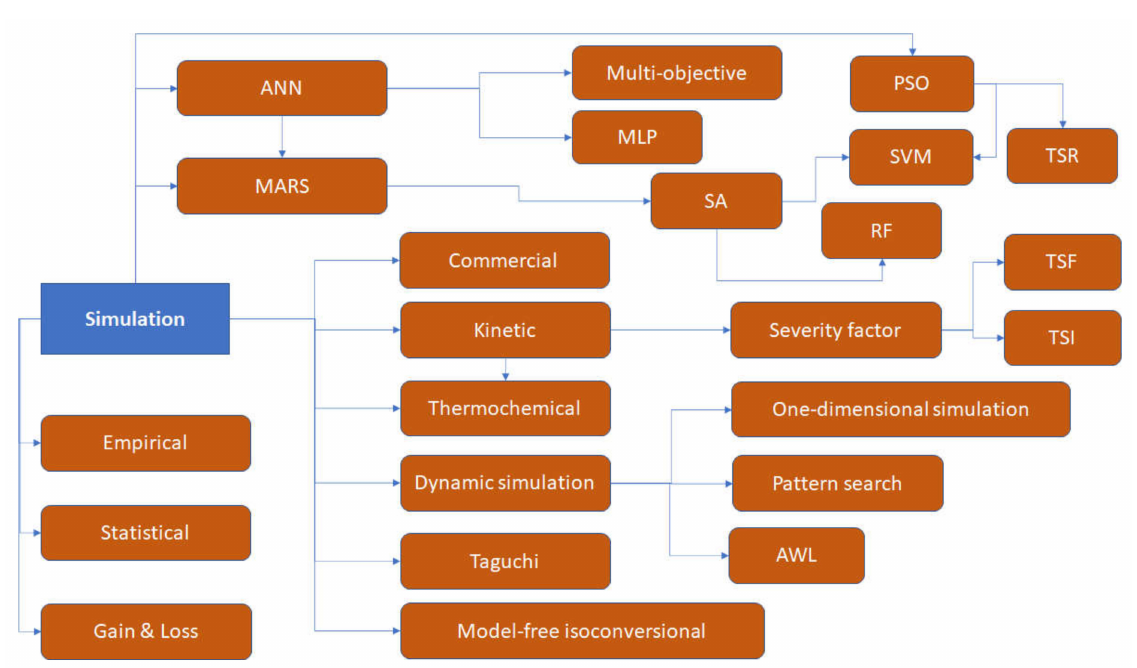
Figure 3. Simulation of dry torrefaction